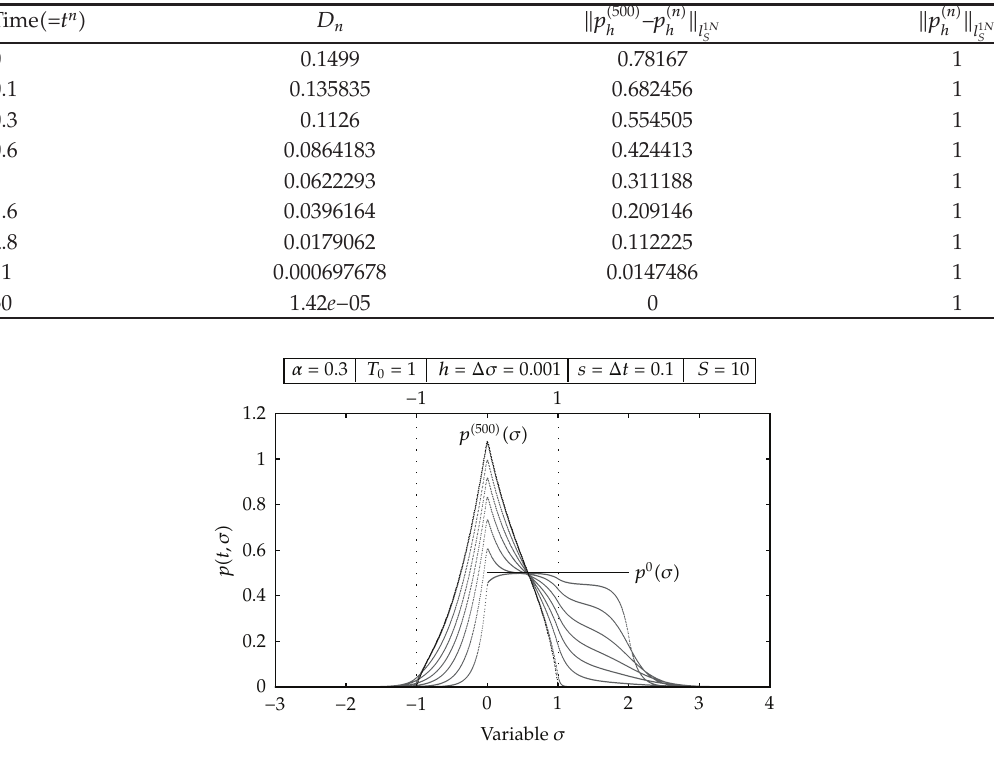
Table 7: Numerical results: Subcase 2.